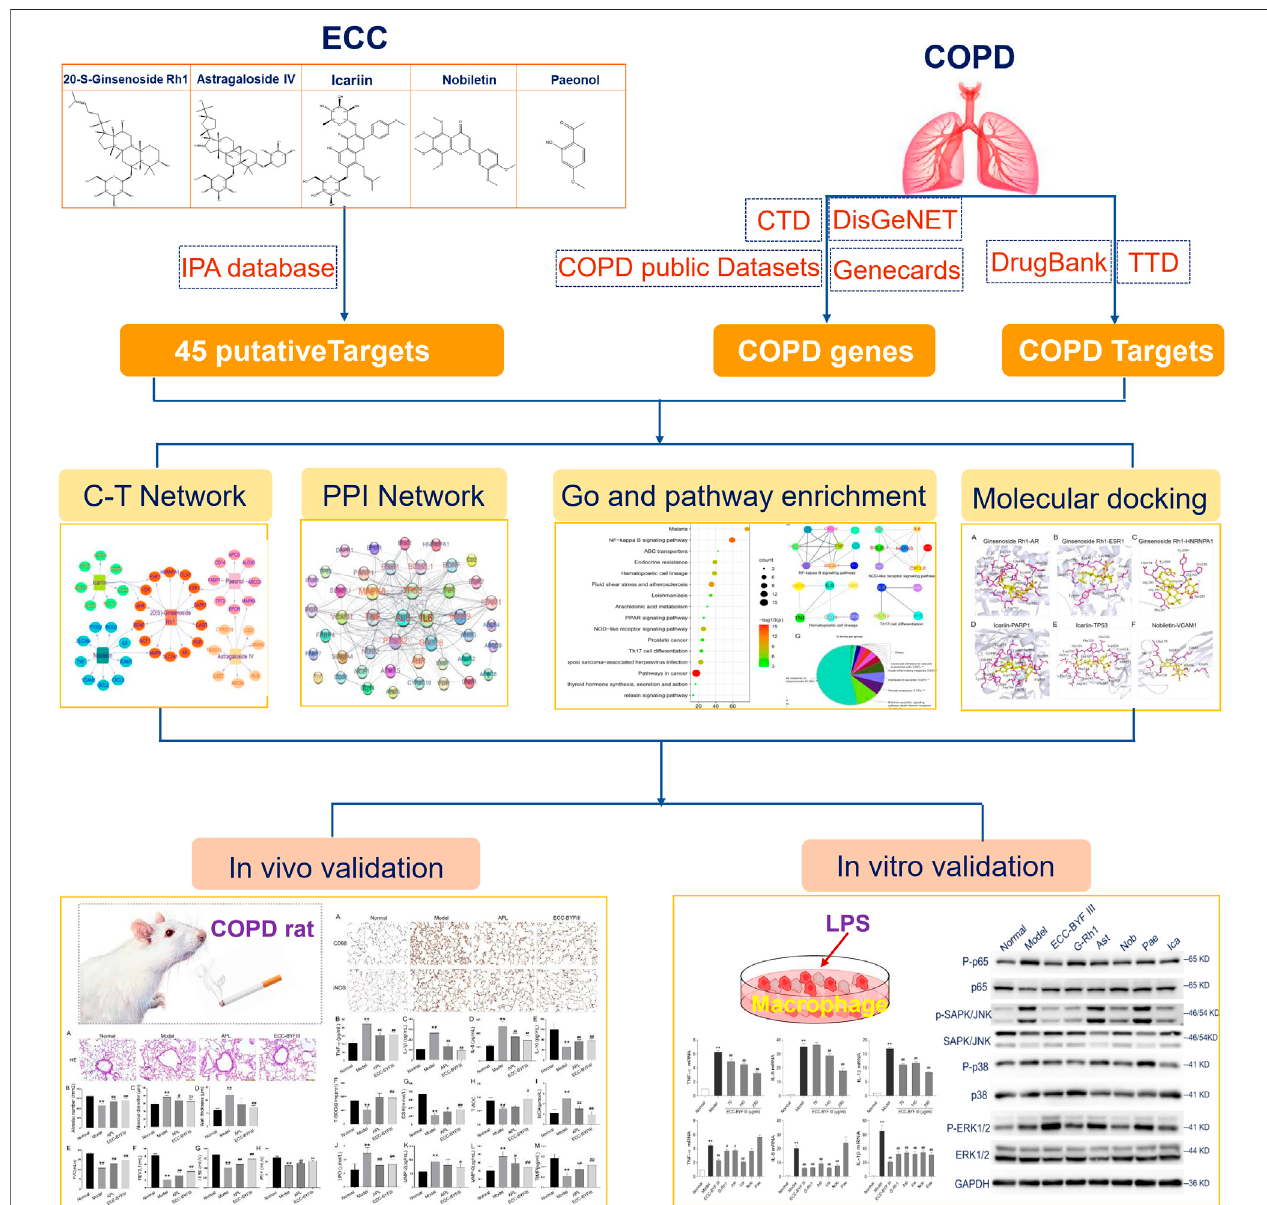
FIGURE 1 | Integrative network pharmacology strategies to investigate the mechanism of ECC for the treatment of COPD.